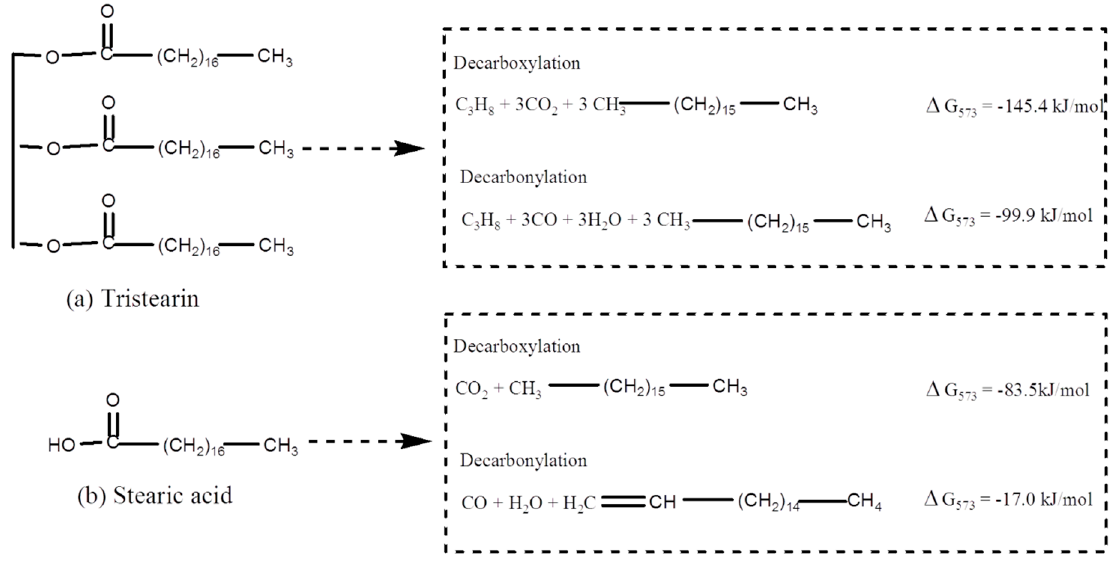
Figure 1. Reaction pathway of deoxygenation (DO) of ( a ) tristearin and ( b ) stearic acid [35].